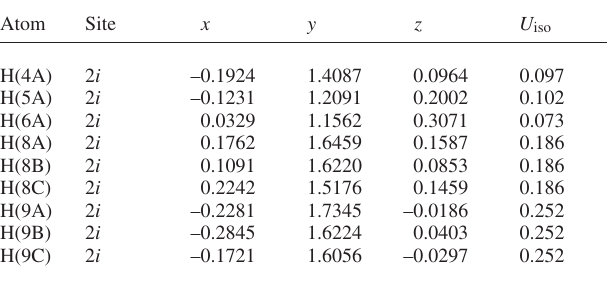
Table 2. Atomic coordinates and displacement parameters (in Å 2 )